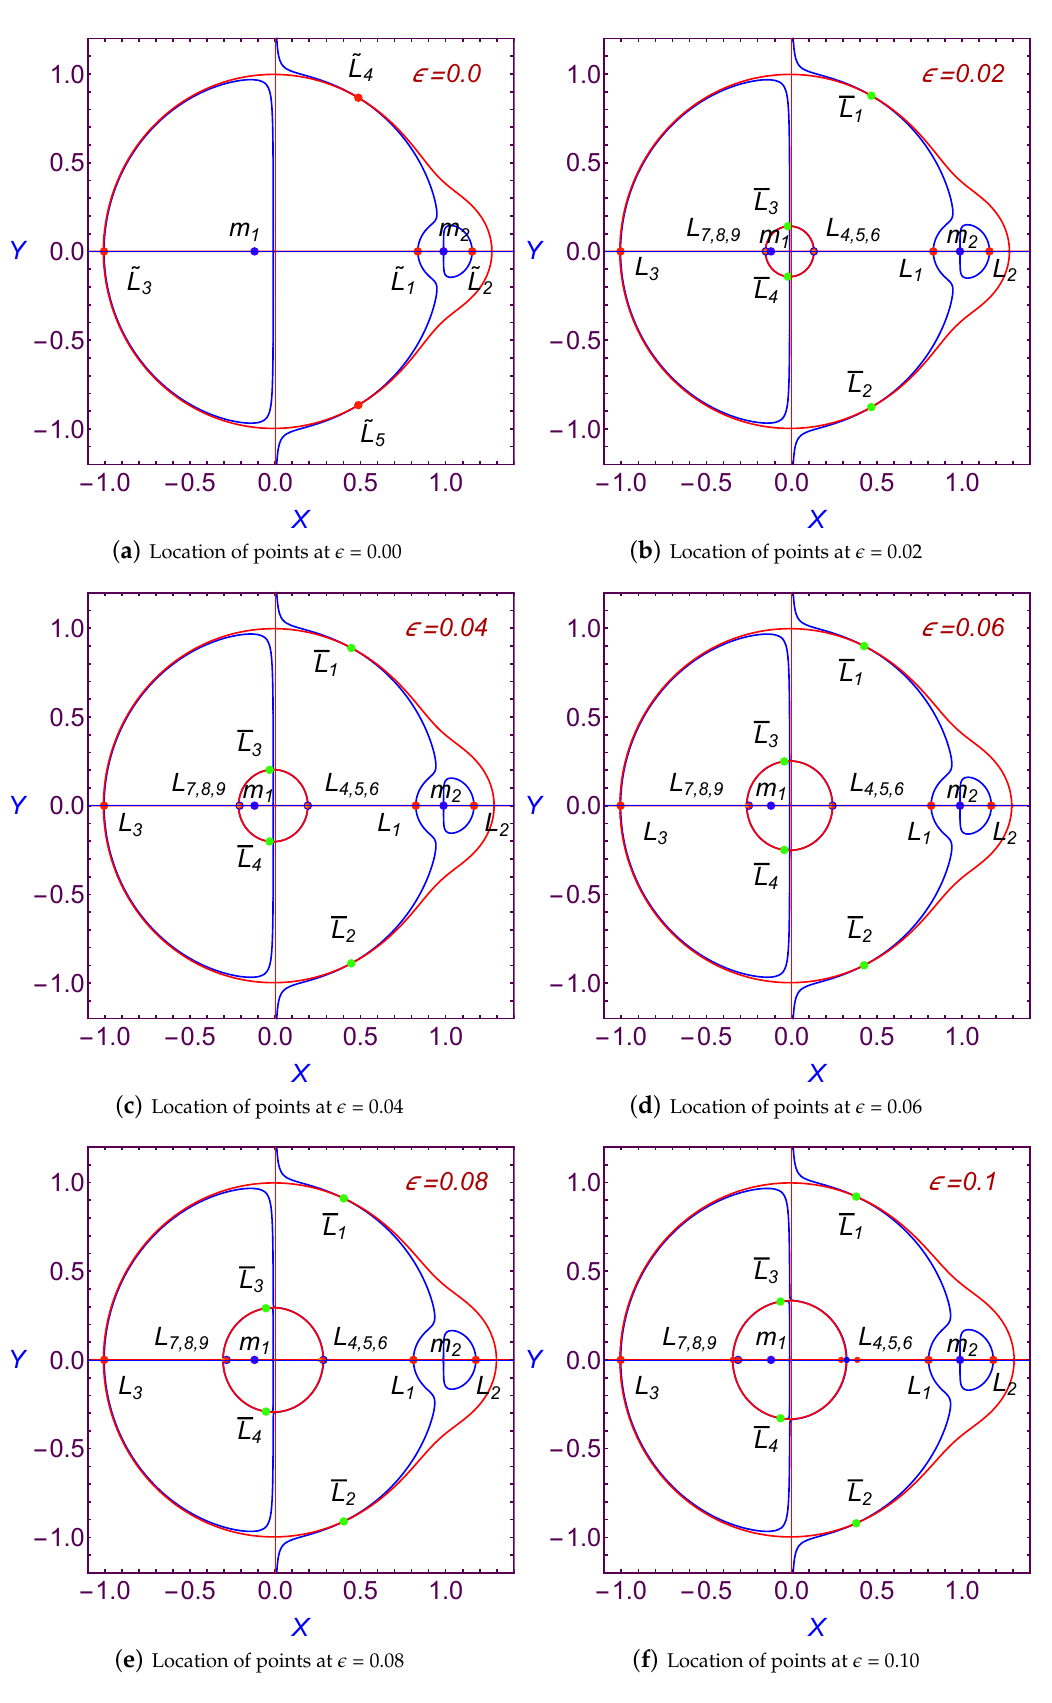
Figure 4. Location of Lagrangian points at different values of (cid:101)